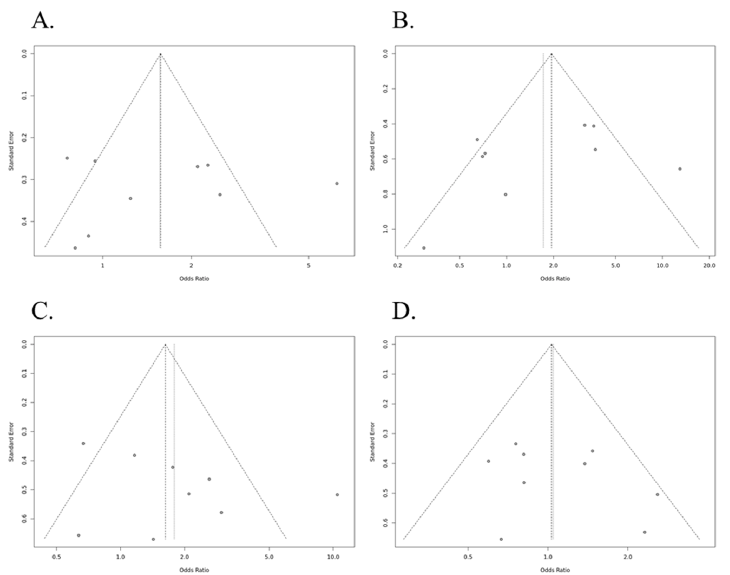
Figure 3. Publication bias in genetic models between HLA-G polymorphism (14-bp insertion/deletion (rs16375)) and susceptibility to acute rejection in kidney transplant recipients. ( A ) Ins vs. Del; ( B ) Ins/Ins vs. Ins/Del+Del/Del; ( C ) Ins/Ins+Ins/Del vs. Del/Del; ( D ) Ins/Del vs. Ins/Ins+Del/Del.